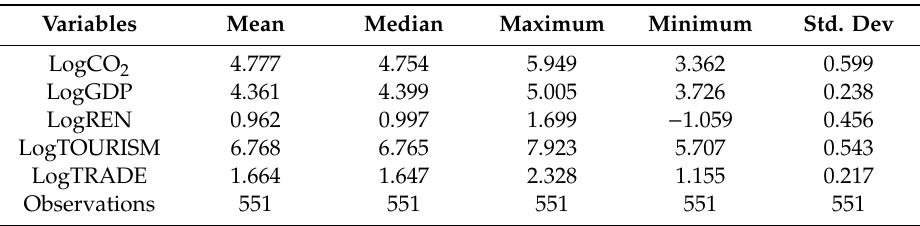
Table 1. Description of the